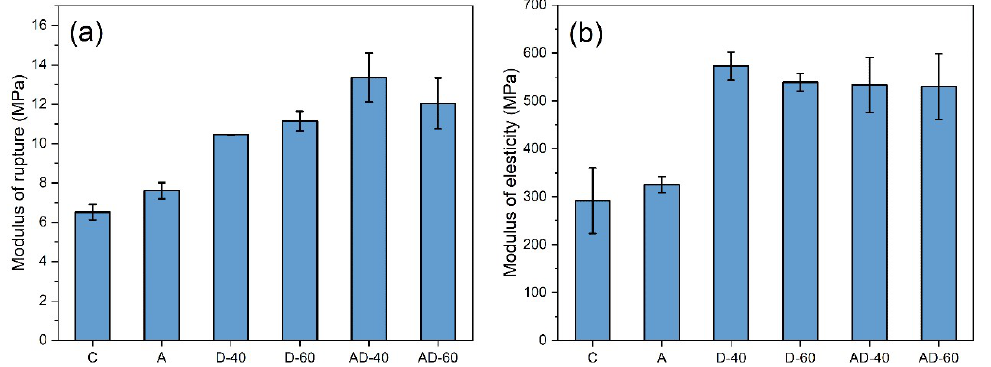
Figure 7. Modulus of rupture ( a ) and modulus of elasticity ( b ) of the control and treated wood samples. Compared to the control sample, the MOR and MOE of D-40 increased by 60.5% and 96.5%, respectively. The MOR of AD-40 further improved by 28.0% compared to D-40, while that of AD-60 had less improvement.